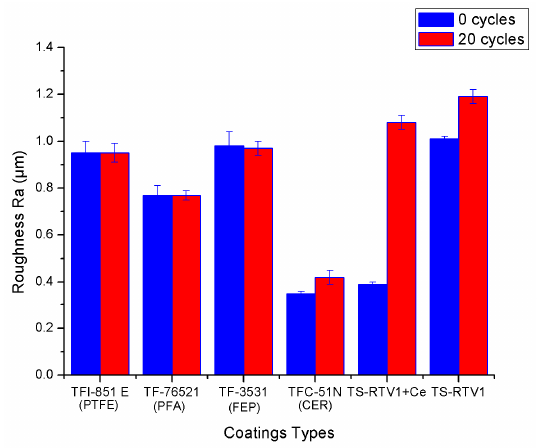
Figure 5. Roughness R a (µm) of the coatings studied. Initial state and after 20 cycles.